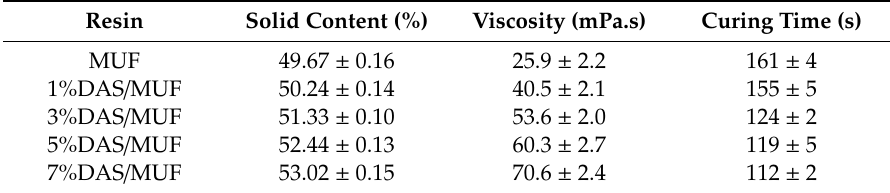
Table 1. Physical properties of neat and DAS-modified MUF resins.